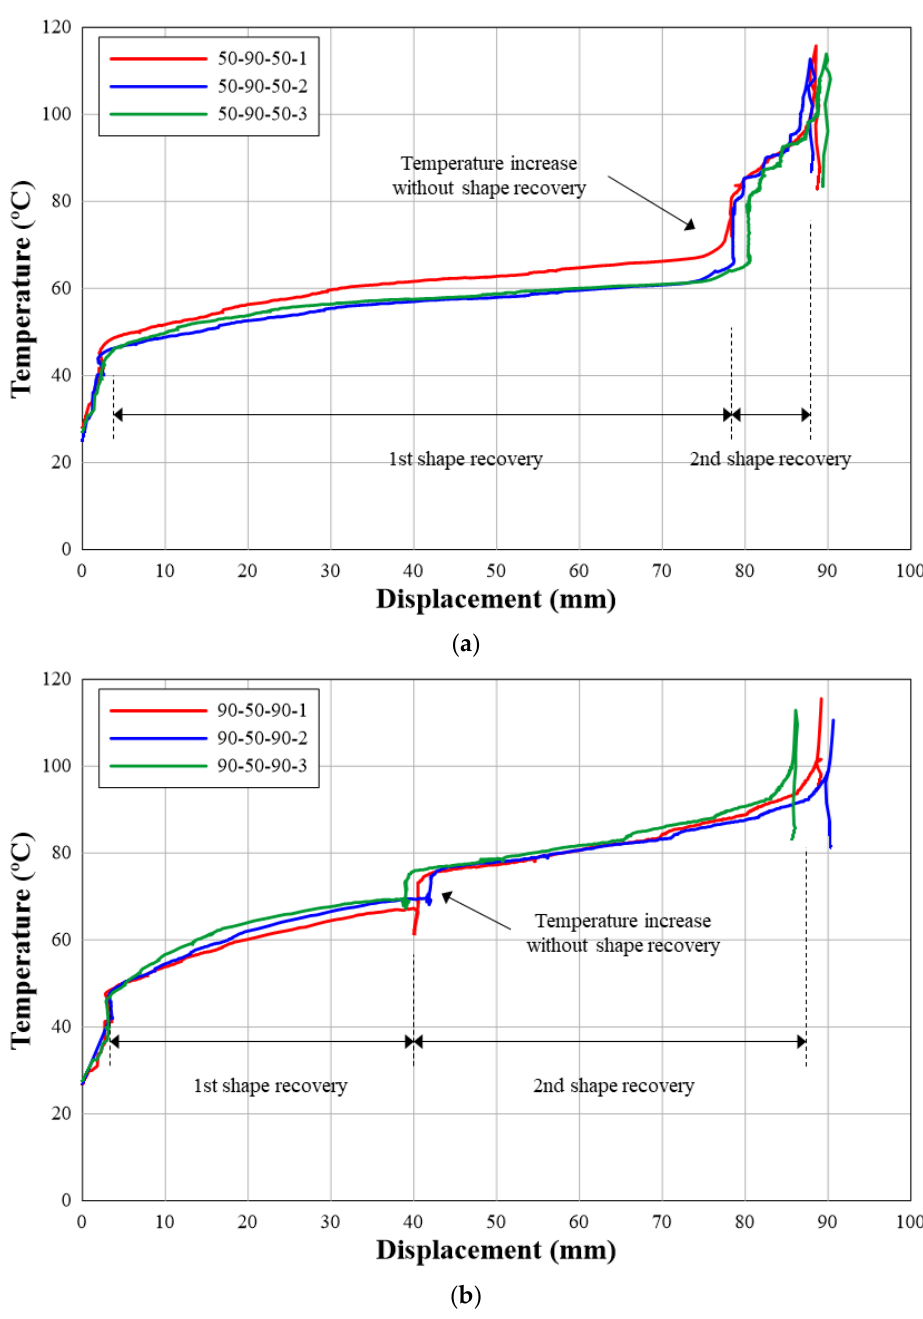
Figure 10. Temperature-displacement relationship of hybrid wire: ( a ) 50-90-50; ( b ) 90-50-90.